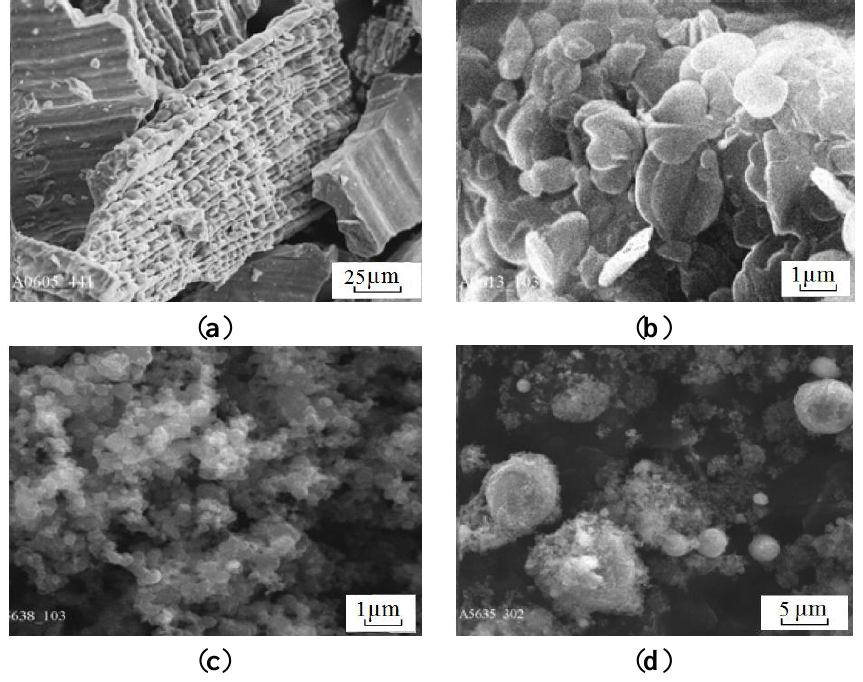
Table 6. Properties of sintered TiN/TiB